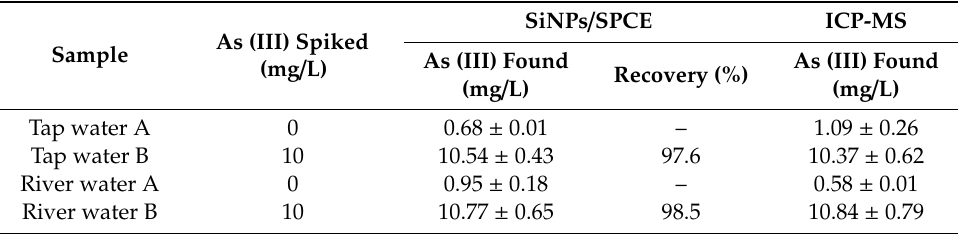
Table 3. Real sample analysis using the developed SiNPs / SPCE sensor for As(III)